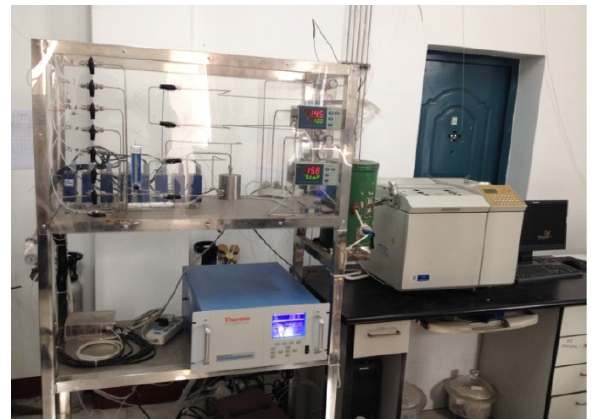
Figure 1: Evaluation